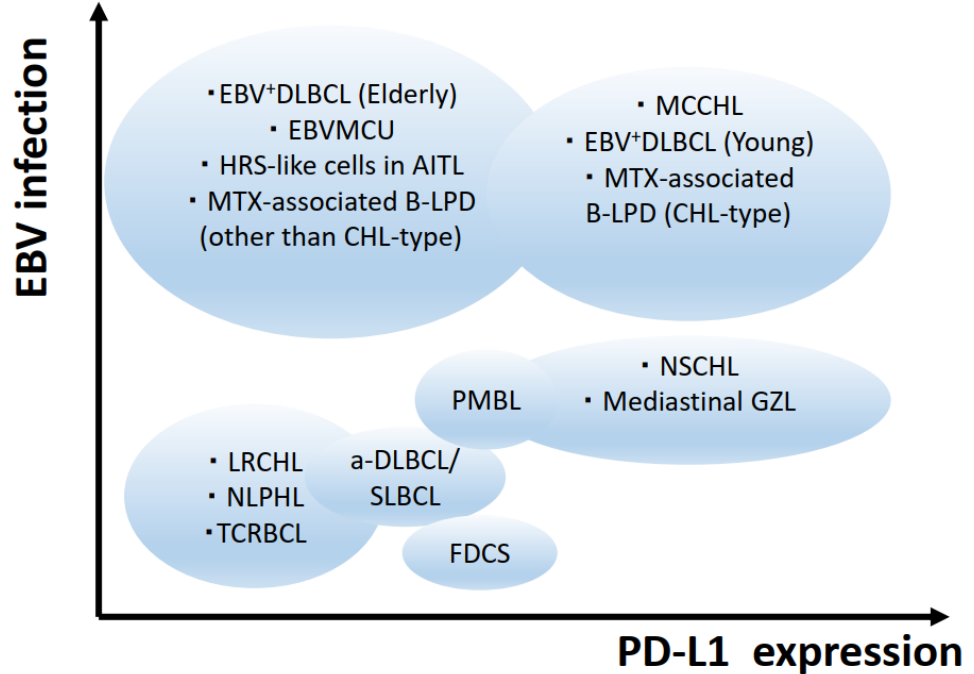
Figure 4. Images of the disease entities of classic Hodgkin lymphoma subtypes and its mimics. EBV = Epstein-Barr virus; AITL = angioimmunoblastic T-cell lymphoma; NSCHL = nodular sclerosis classic Hodgkin lymphoma; LRCHL = lymphocyte-rich classic Hodgkin lymphoma; MCCHL = mixed cellularity classic Hodgkin lymphoma; NLPHL = nodular lymphocyte-predominant Hodgkin lymphoma; DLBCL = diffuse large B-cell lymphoma; EBVMCU = EBV-positive mucocutaneous ulcer; MTX = methotrexate; LPD = lymphoproliferative disorder; PMBL = primary mediastinal large B-cell lymphoma; GZL = B-cell lymphoma unclassifiable, with features intermediate between DLBCL and CHL/Gray zone lymphoma; TCRBCL = T-cell/histiocyte-rich large B-cell lymphoma; a-DLBCL = an- aplastic variant of DLBCL; SLBCL = sinusoidal large B-cell lymphoma; FDCS = follicular dendritic cell sarcoma. 4.1.1. Primary Mediastinal Large B-Cell Lymphoma and B-Cell Lymphoma Unclassifiable, with Features Intermediate between DLBCL and CHL (Gray Zone Lymphoma) Primary mediastinal large B-cell lymphoma (PMBL) and NSCHL share a number of common features, including preferential mediastinal involvement, female predominance, common occurrence in young adults, and large tumor cells with sclerosis. Sequential de- velopment of CHL and PMBL in the same patient has been reported, suggesting common pathogenesis of CHL and PMBL [120]. Gene expression profiling and genetic profiles fur- ther support a close relation between these two diseases [121]. Nevertheless, the therapeu- tic approach differs between these diseases, and thus CHL must be distinguished from PMBL for clinical management [122]. Unlike CHLs, the prototypical PMBL shows a mon- omorphous infiltrate of large cells with a sparse inflammatory background, and diffuse positive staining of pan-B-cell markers [123]. The differential diagnosis of CHL versus B-cell lymphoma unclassifiable, with fea- tures intermediate between DLBCL and CHL (mediastinal gray zone lymphoma: MGZL), is even more complicated. MGZL was originally proposed to be a disease representing the missing link between CHL and MLBCL [120]. Some MGZL cases exhibit a character- istic CHL immunophenotype with histologic appearance suggestive of MLBCL, while